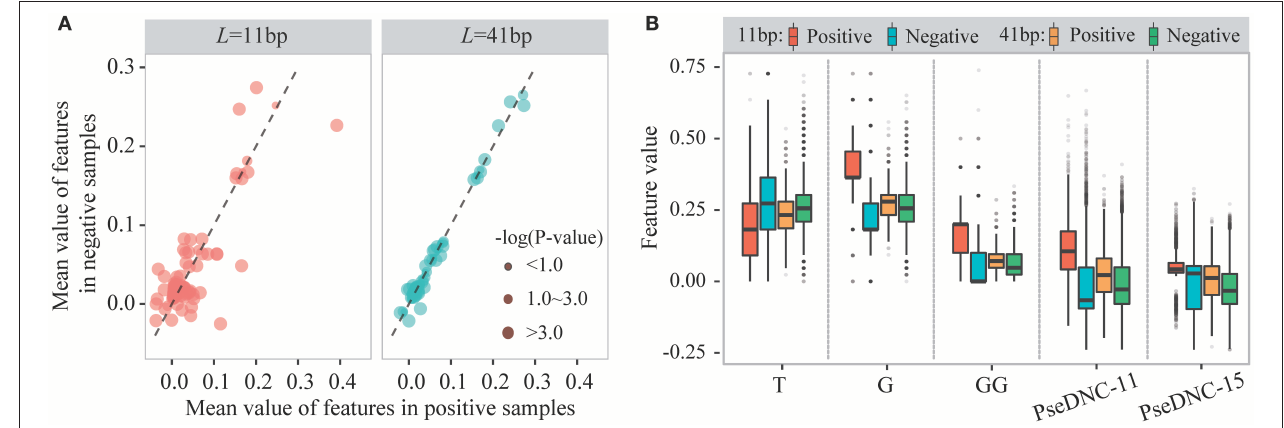
FIGURE 4 | The different distribution of k-mer and PseDNC features between positive and negative samples. (A) The differences of k-mer and PseDNC features between positive and negative samples based on the mean value difference and two-sample t -test. (B) The feature distribution is different between the positive and negative samples and affected by the window